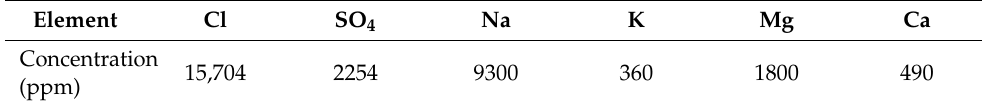
Table 9. Atlantic Ocean seawater analysis used to represent the seawater (taken from [36]).